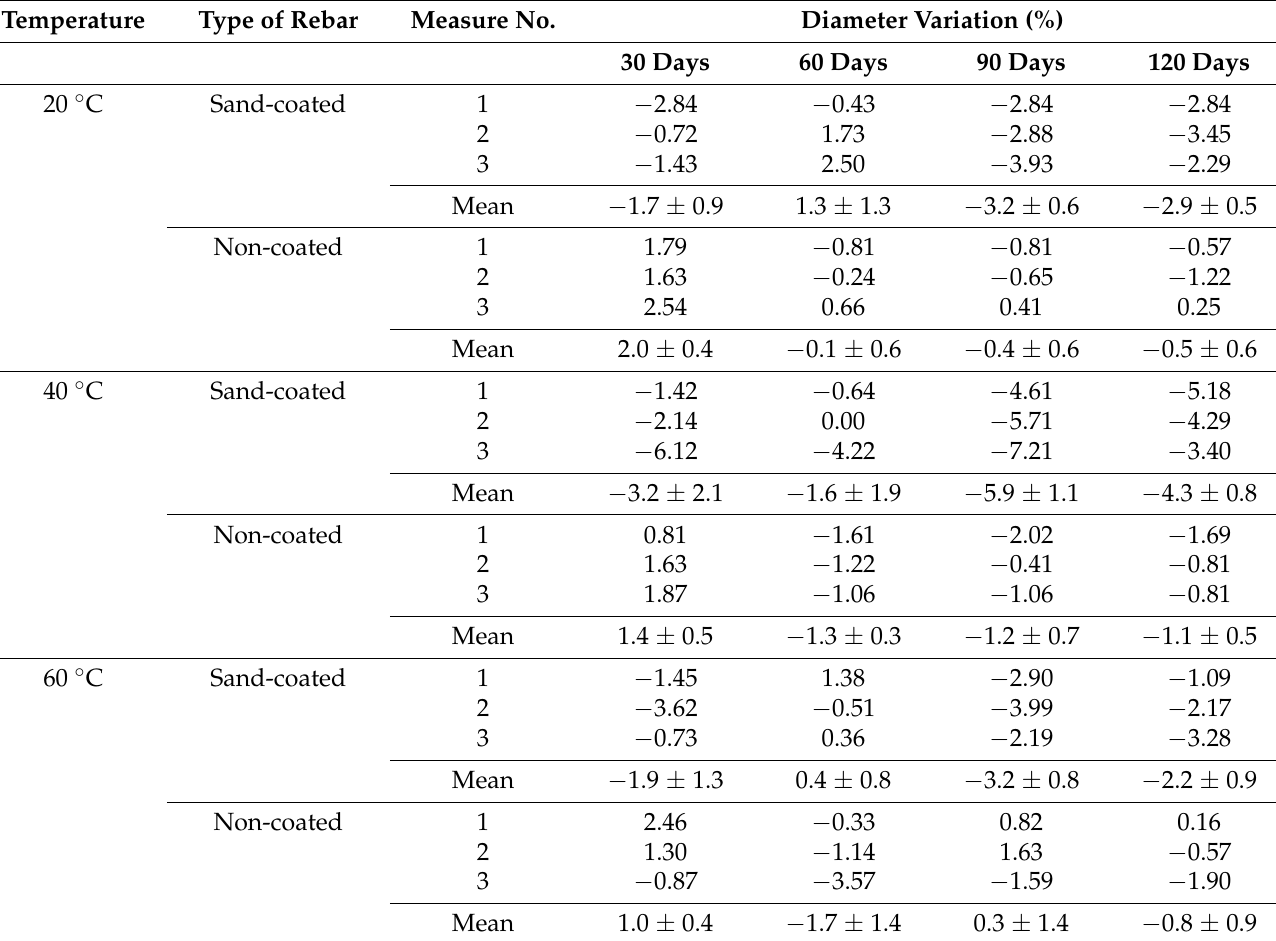
Table 4. Diameter variations of GFRP rebars subjected to direct immersion in the alkaline solution.